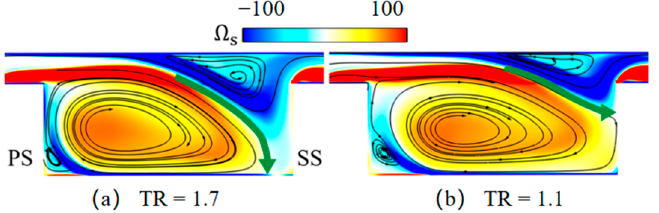
Figure 8. Comparisons of normalized vorticity distributions on a cut plane of the tip gap for two TRs.